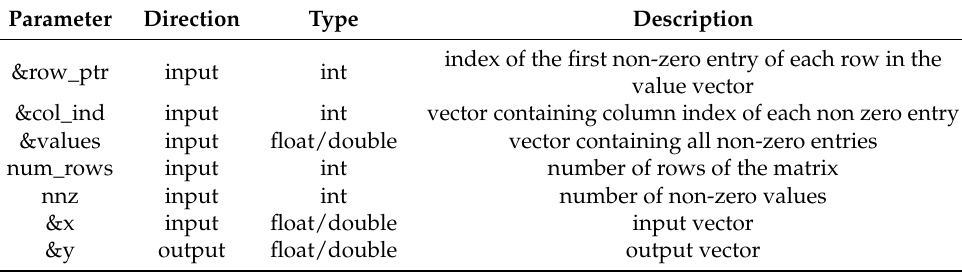
Table 7. Input and output parameters for kernel